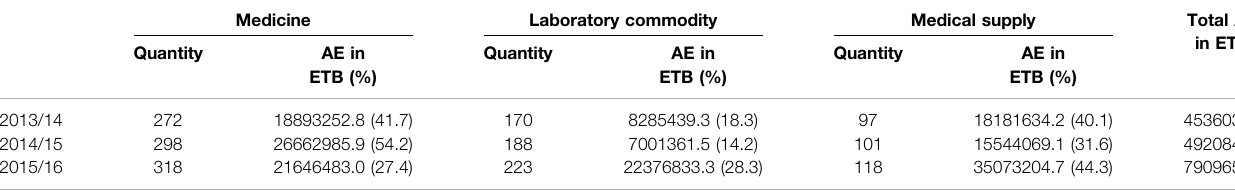
TABLE 1 | Annual expenditures on health commodities at SPHMMC for 2013/14 – 2015/16.